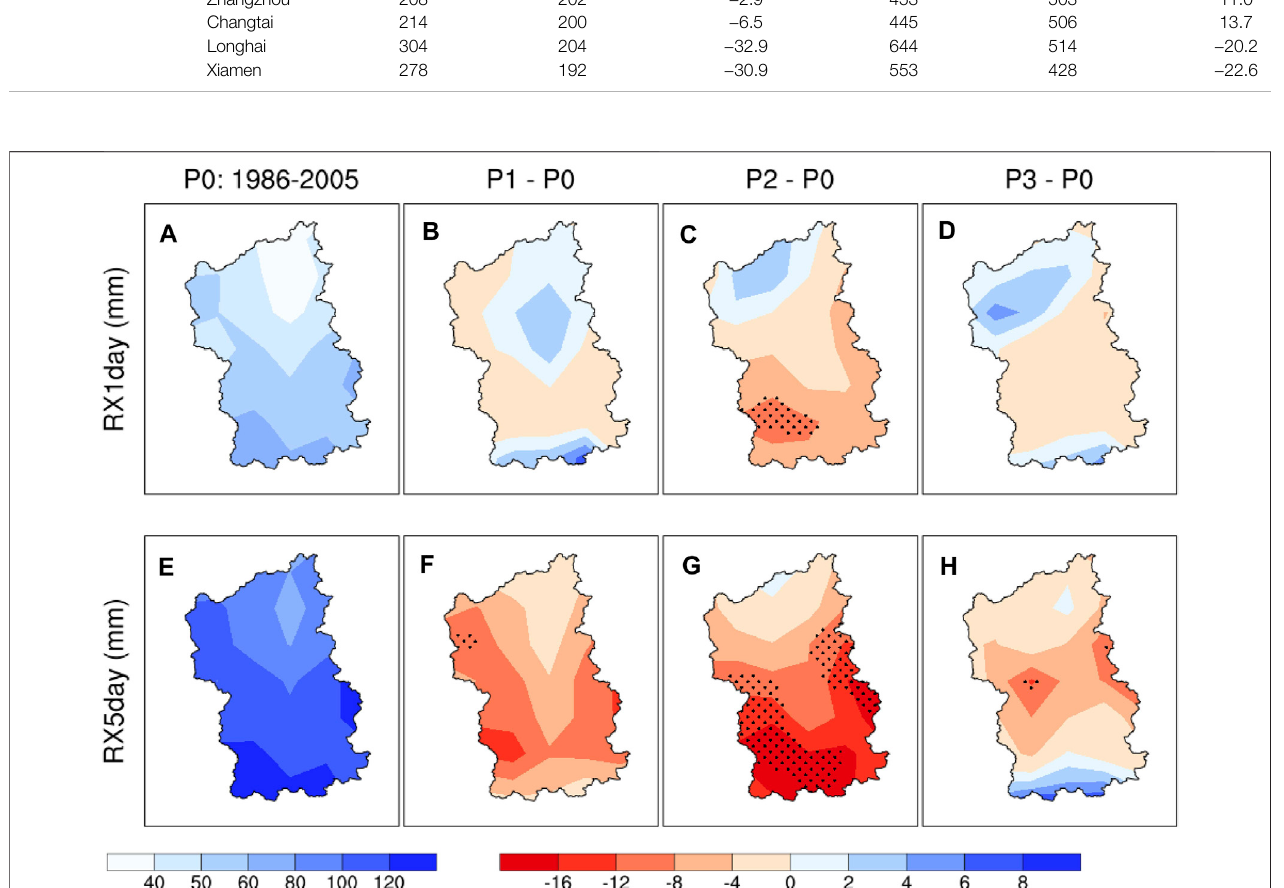
FIGURE4| Spatial distributionofpresent-day (P0: 1986 – 2005) mean (A) RX1day and (E) RX5dayfor theentire rainyseason inJRB,and the projected changesin precipitation extremes for (B – D) RX1day and (F – H) RX5day during the near-future P1 (2021 – 2040), mid-future P2 (2041 – 2060), and far-future P3 (2081 – 2098) relative to the present-day. The black dots indicate statistically signi fi cant changes at 90% con fi dence level.